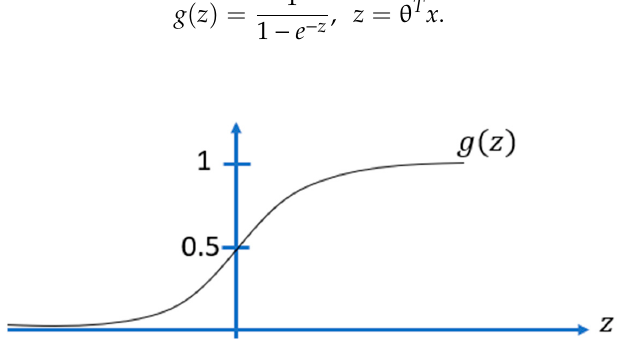
Figure 15. The sigmoid function g ( z ) of Equation (19).